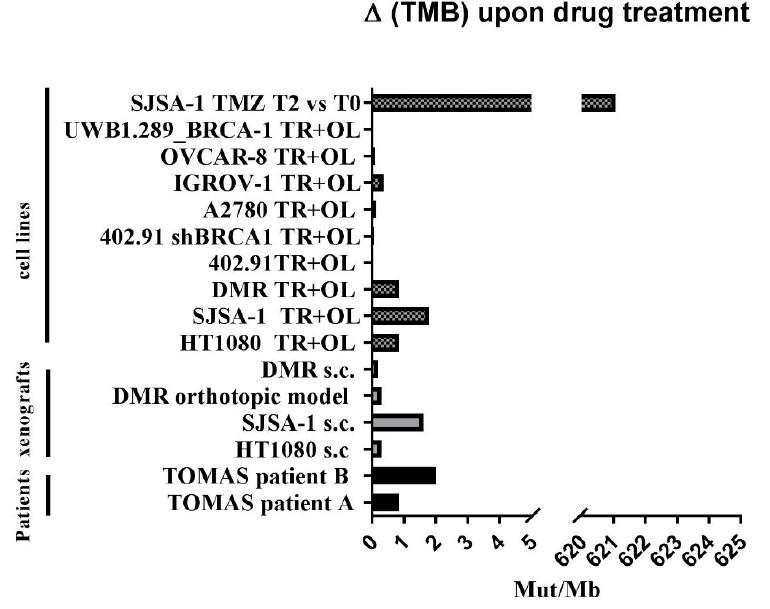
Figure 6. Variations in tumor mutational burden ( Δ TMB) in a preclinical and translational platform of bone and soft tissue sarcomas treated with trabectedin + olaparib (TR + OL). TMB was calculated on somatic mutations identified on WES or targeted panel sequencing (Oncomine TML). Results are shown as alterations in the number of mutations per megabase, in treated samples vs. their untreated/baseline controls.